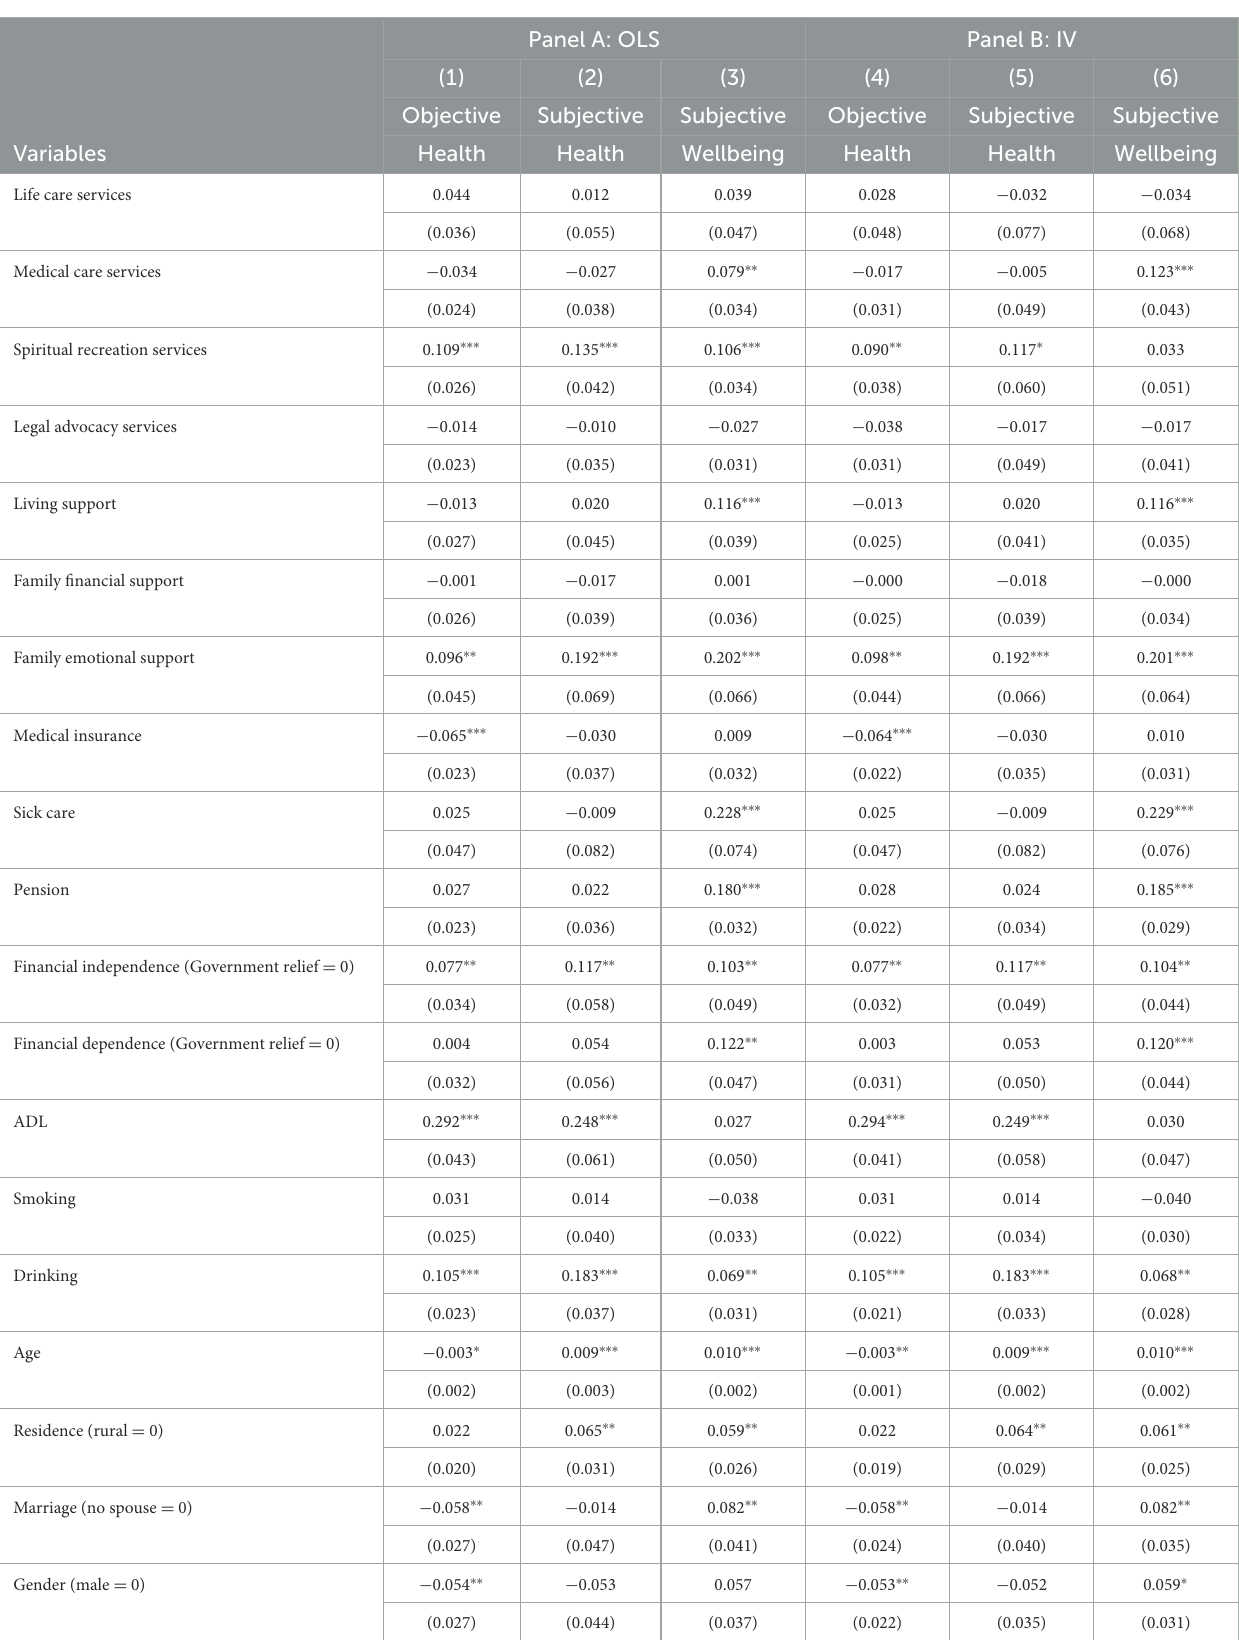
TABLE 3 Estimation results for different types of community care services and the health of older